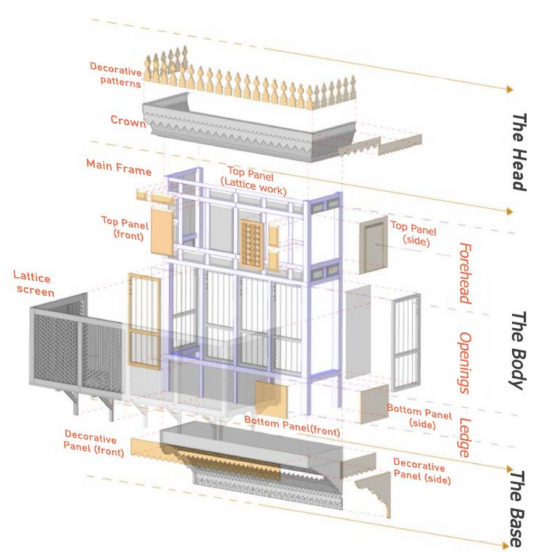
Figure 4. Detailed view of parts and components for a mashrabiya in Jeddah, amended from Alitany et al. [20].